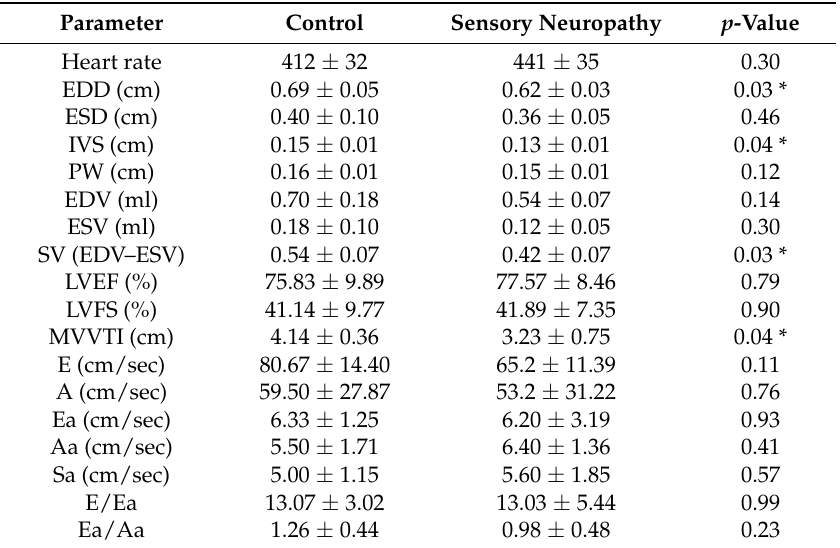
Table 2. Effect of sensory neuropathy on myocardial morphology and function assessed by transthoracic